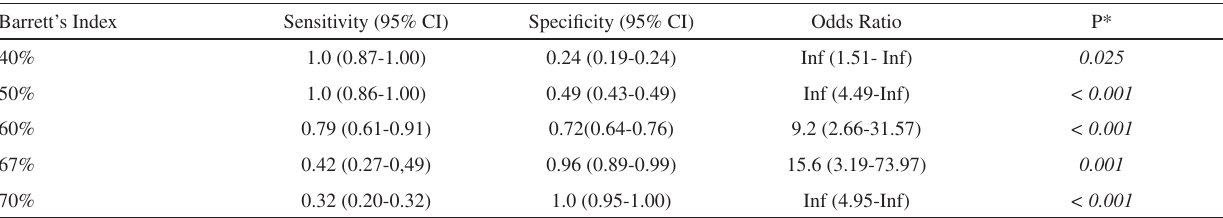
Table 2 - The sensitivity, specificity and odds ratios with confidence intervals (CI) of several levels of Barrett’s index for the diagnosis of 19 orbits with dysthyroid optic neuropathy and of 45 orbits of patients with Graves’ Orbitopathy without dysthyroid optic